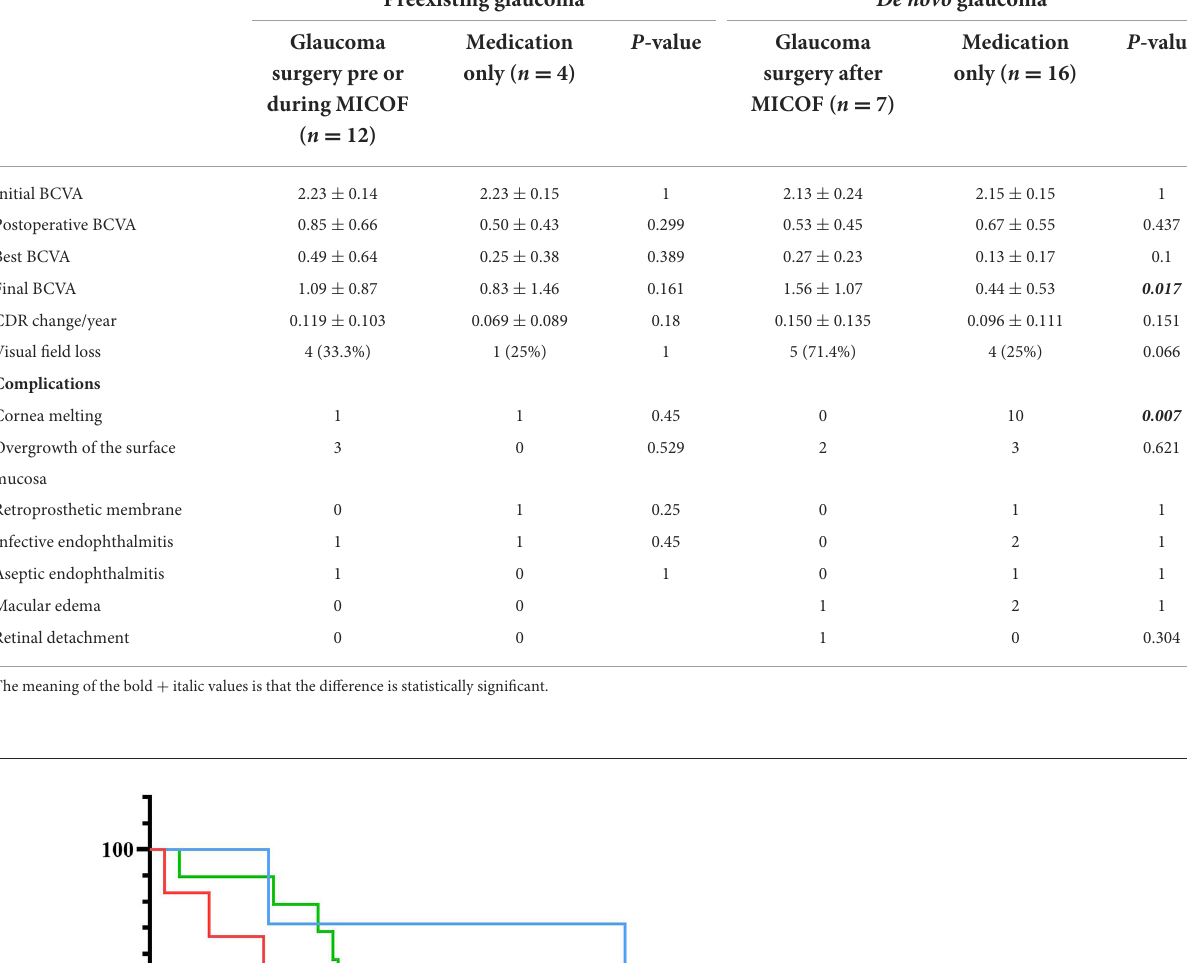
TABLE 3 Comparison of the glaucoma surgery group and the medication group.